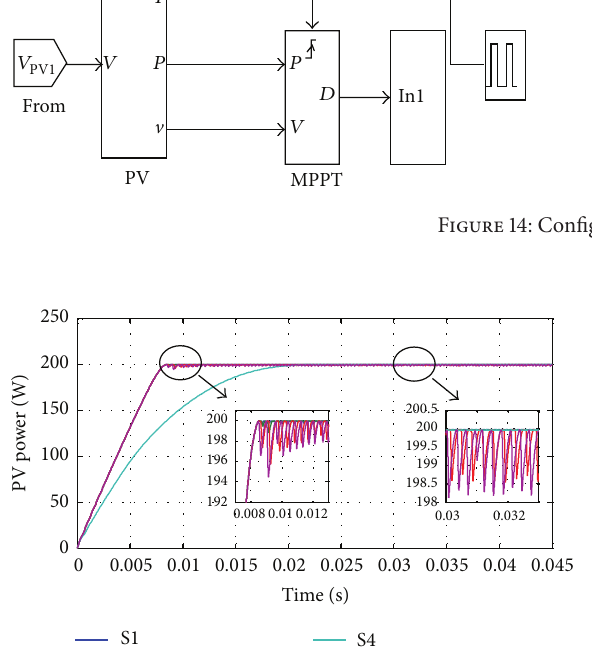
, is 450 𝜇 F, and the load out